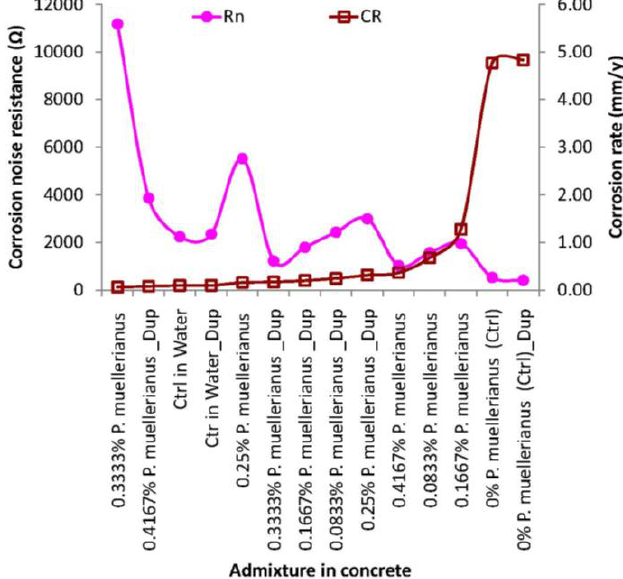
Figure 3. Plots of noise resistance and corrosion rate in ranking order of corrosion rate performance of P. muellerianus admixtures in concrete samples.